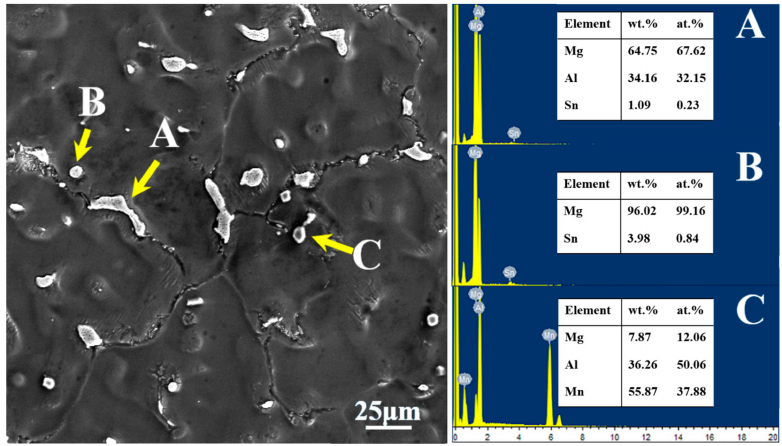
Figure 3. The EDS results of the main phases in the as-cast AT71-0.4Mn alloy. ( A ) Mg 17 Al 12 ; ( B ) Mg 2 Sn; ( C ) Al-Mn phase.